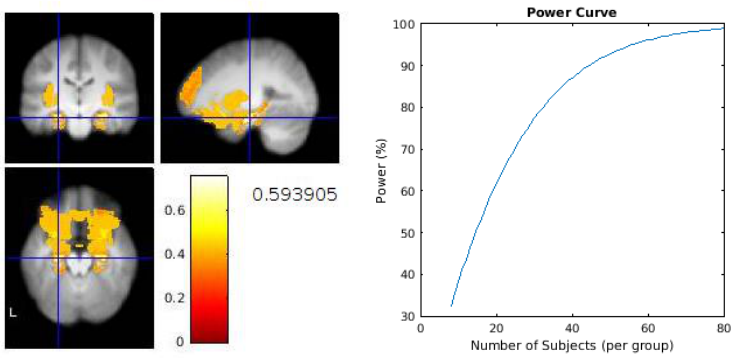
Figure B1. Hippocampus Figure B2 . Hypothalamus. Figure A2. Hippocampus